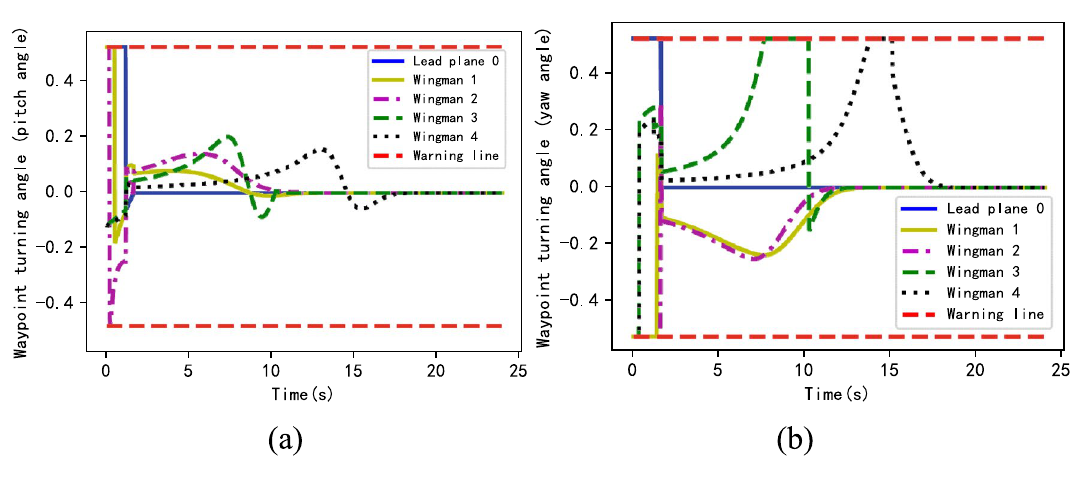
Figure 7. The waypoint turning angle ( a ): pitch angle; ( b ): yaw